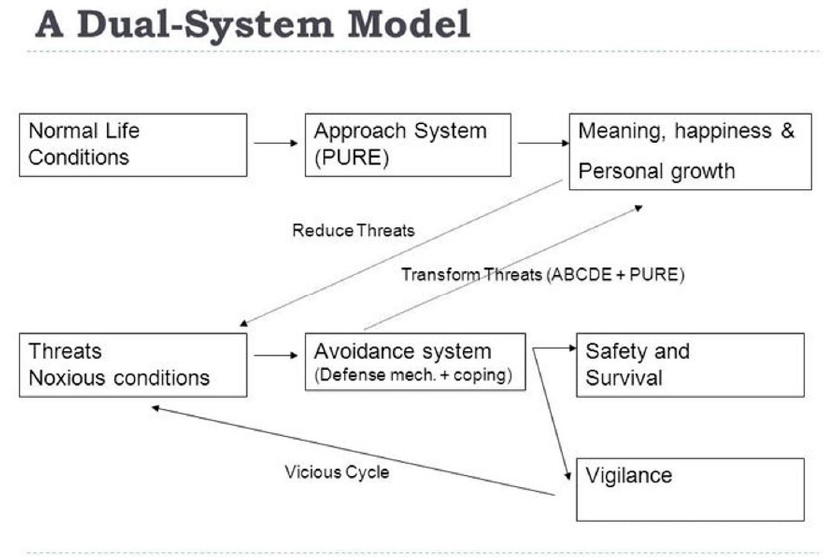
Figure 2. A Dual System Model of What Makes Life Worth Living.